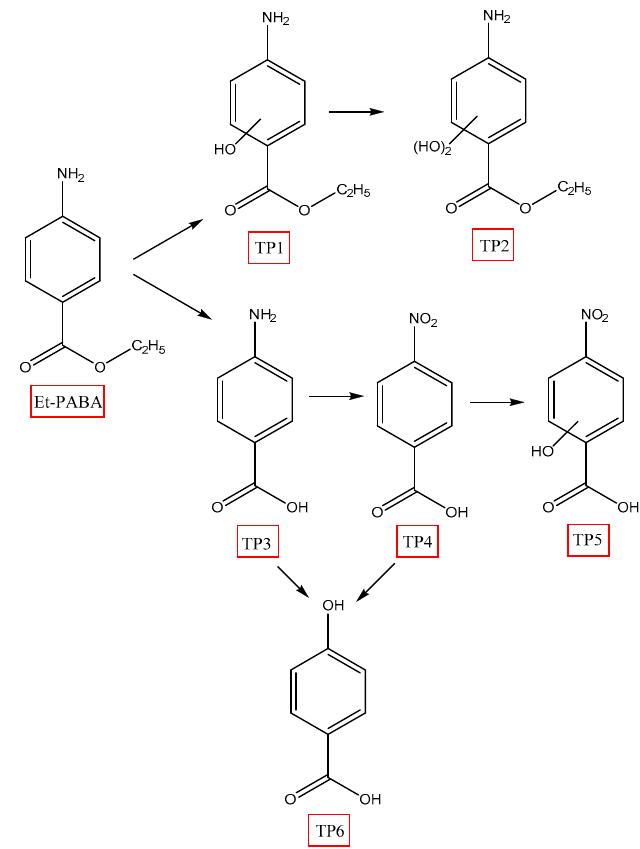
Figure 6. Proposed reaction pathways for the oxidation of Et-PABA using the UV/PDS process.